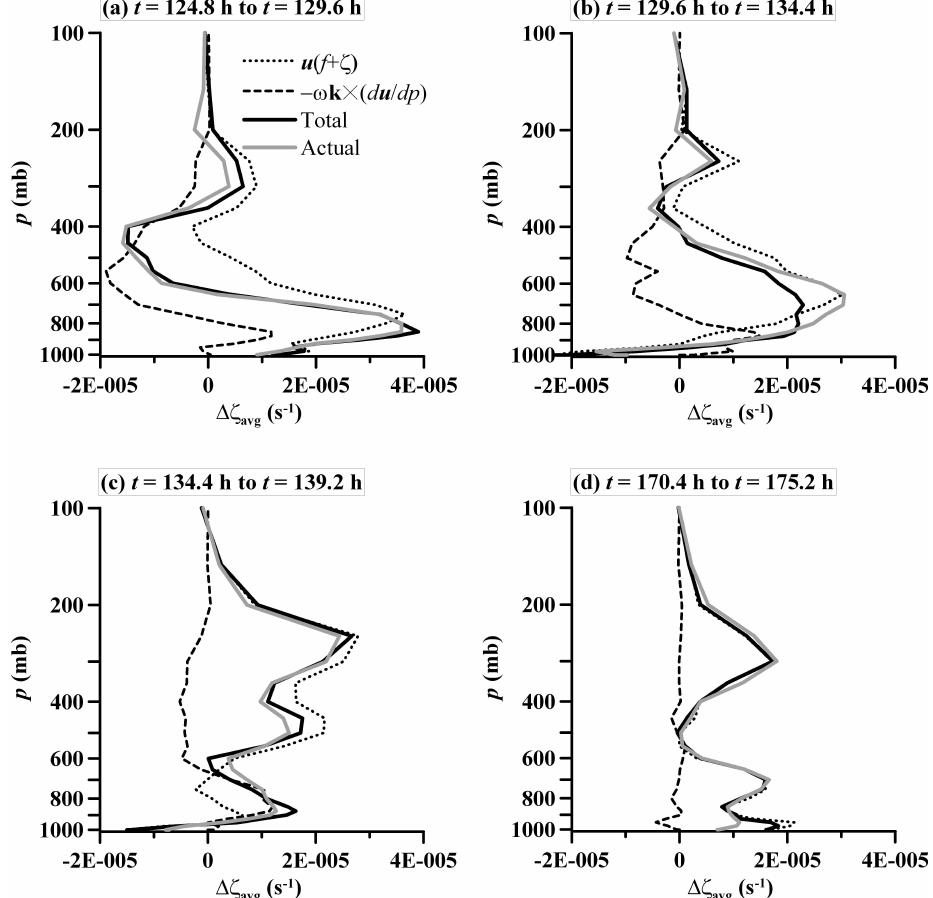
Fig. 3. Circulation budget analysis expressed as area average vorticity change for a rectangle surrounding the vortex in the control simulation on the 3.3-km grid for the time periods: (a) 124.8h to 129.6h; (b) 129.6h to 134.4h; (c) 134.4h to 139.2h; and (d) 170.4h to 175.2h, respectively. The dotted line indicates the line integral of horizontal flux convergence of absolute vorticity; the dashed line is the correspond- ing, tilting-like term; the solid black line is the total of the horizontal and tilting-like terms; and the solid gray line is the actual change over the period of